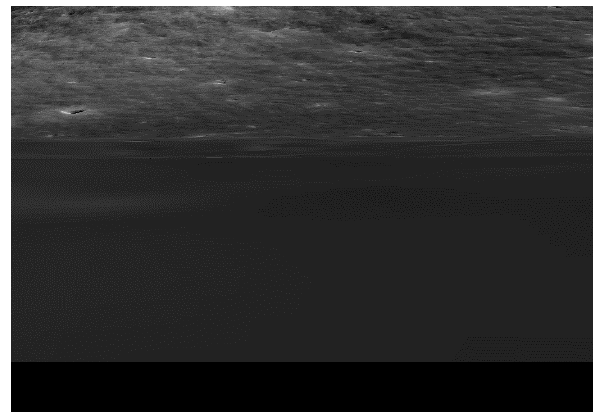
Figure 2. Example of artificial surface image modelling from different observation height: upper - 30 m; lower - 2 m (Observation coordinates: 25.78469°; 30.80354°, azimuth 190°, downward pointing angle 5°).